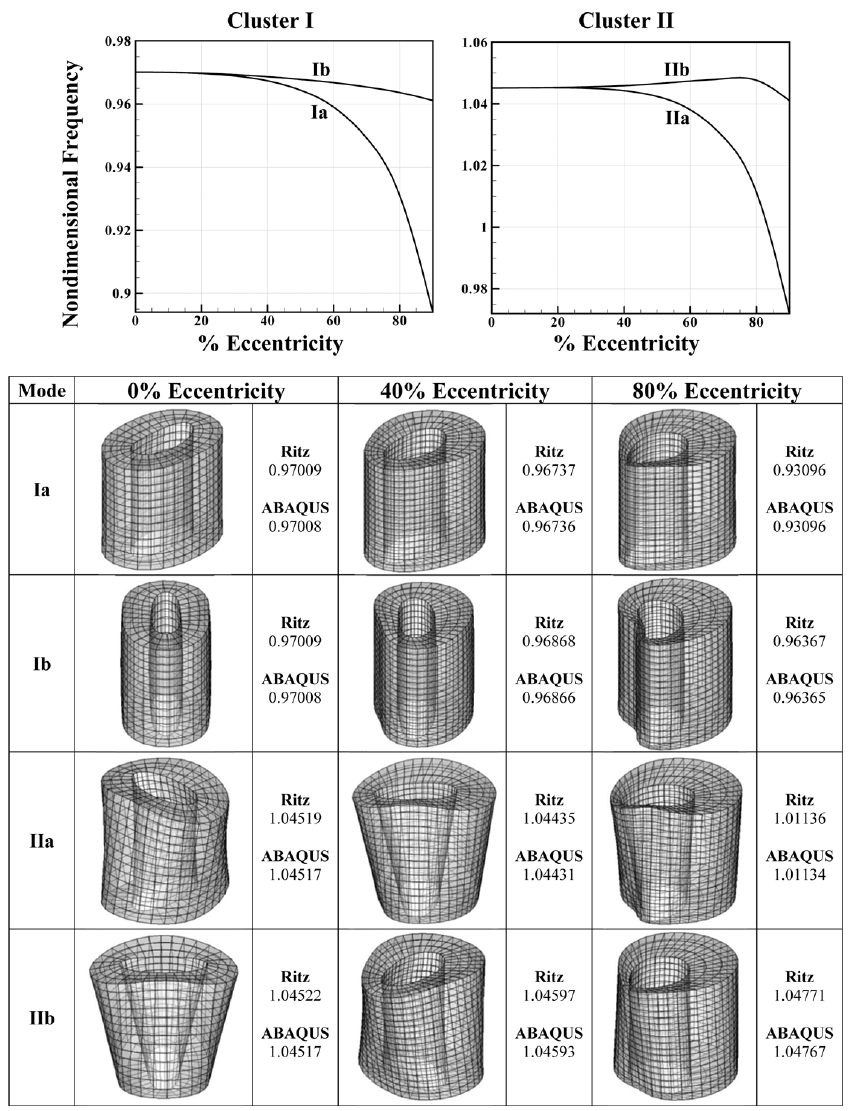
Fig. 5. Variation of the fi rst two frequency clusters with eccentricity parameter for the fi nite cylinder with an internal cylindrical cavity, along with the fi rst four three-dimensional mode shapes for selected eccentricity parameters. As eccentricity is introduced, characteristically different effects on natural frequencies are observed, depending on the problem geometry and mode number. In particular, none of the frequency clusters remain fully degenerate, and the imposed asymmetry causes some or all of the repeated vibration modes to split into modes with distinct natural frequencies. More speci fi cally, it is observed that clusters (II, III) are two-fold degenerate and split into sub-clusters (IIa,b; IIIa,b) in Fig. 2, cluster I is two-fold degenerate and split into sub-clusters Ia,b in Fig. 3,